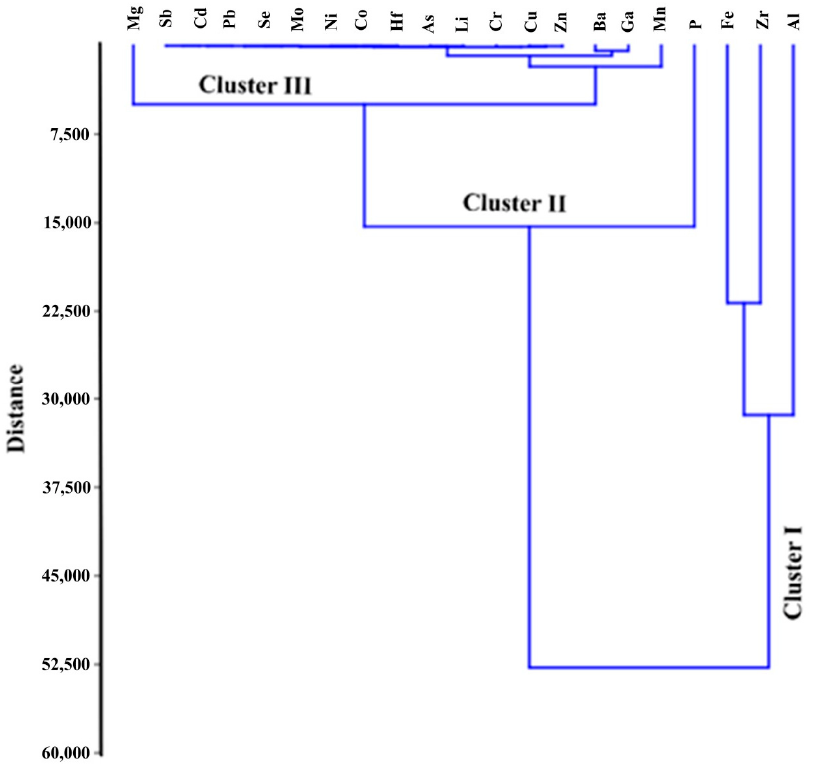
Figure 5. Dendrogram showing the clusters of metals in Qaroun Lake sediment samples.